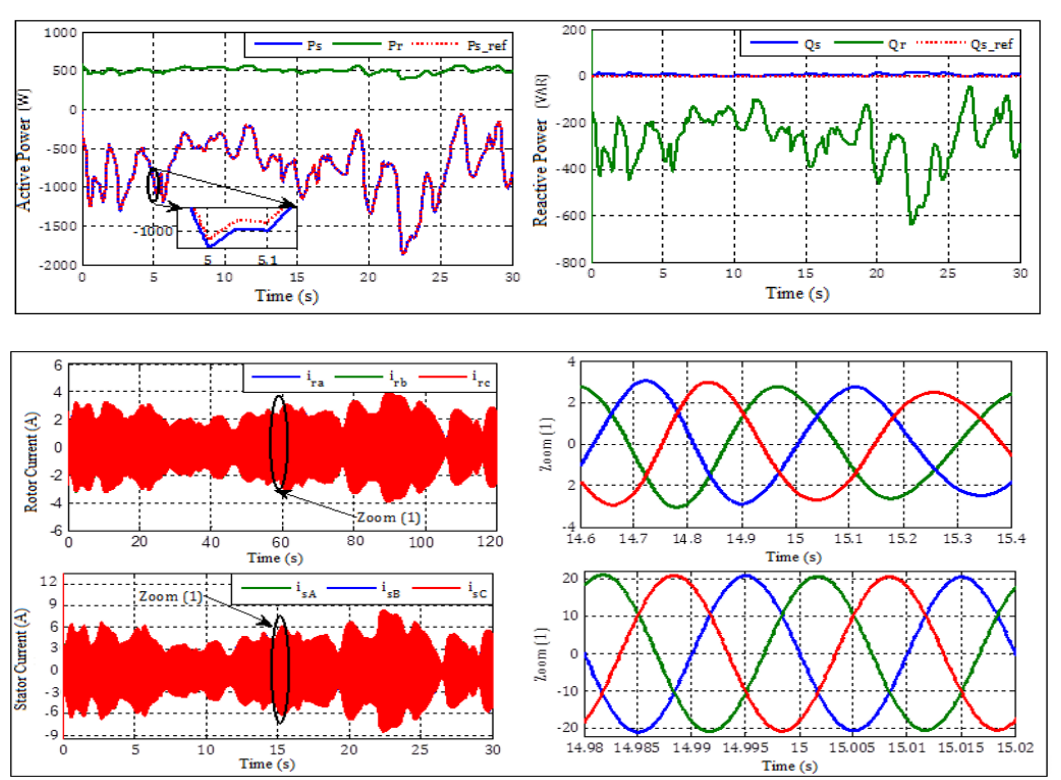
Figure 3. Real variable wind speed system response.